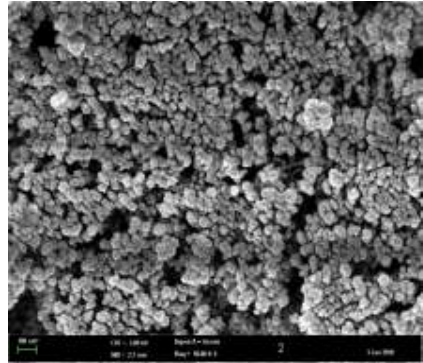
Figure 2: FESEM images of the LaFeO3 powder sample with glucose/citric acid calcined at 400 °C for 2